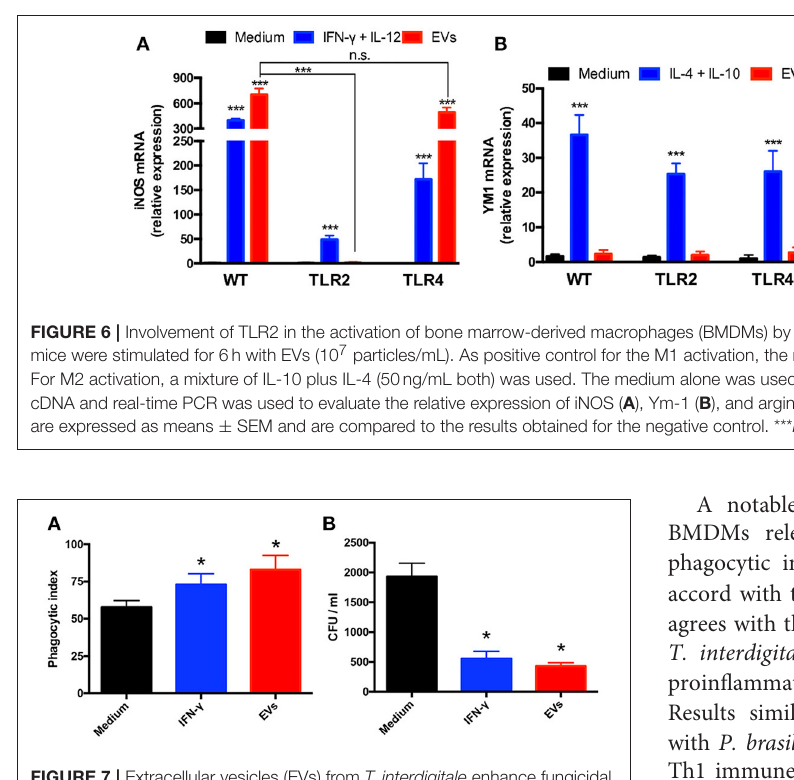
FIGURE 7 | Extracellular vesicles (EVs) from T. interdigitale enhance fungicidal activity of macrophages. ( A ) Before the addition of T. interdigitale to bone marrow-derived macrophages (BMDMs; conidia:macrophages = 1:1), the cells were treated for 30min with EVs (10 7 particles/mL), IFN- γ (50ng/mL), or the medium and then plated on glass coverslips; after incubation for 4h at 37 ◦ C, the coverslips were washed with PBS, and the cells were stained with Giemsa and the phagocytic index determined. ( B ) Alternatively, BMDMs were infected with T. interdigitale (macrophages:conidia = 1:1) for 48h and then the cells were washed and lysed for the detection of viable intracellular fungal cells based on measuring their CFU. Data are representative of 3 experiments. The results are expressed as means ± SEM and are compared to the results obtained for the negative control. * P <